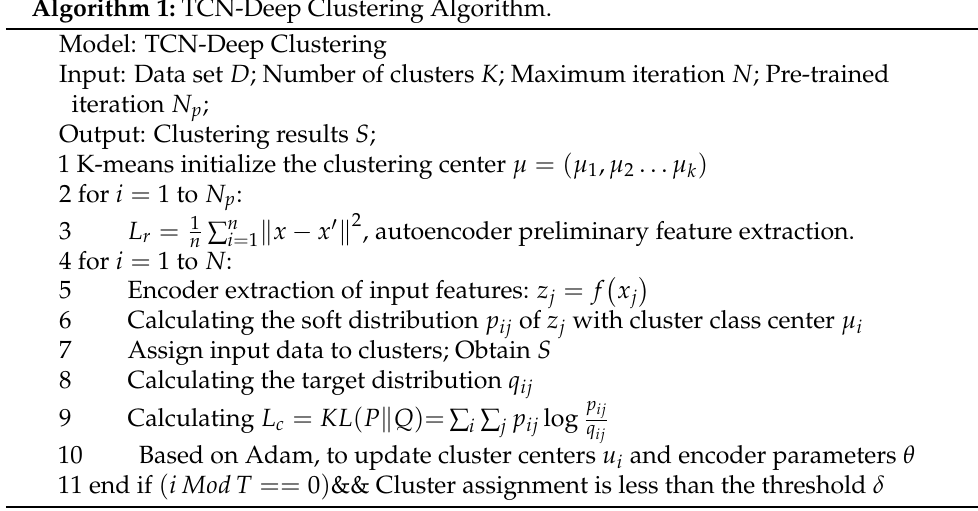
Algorithm 1: TCN-Deep Clustering Algorithm. Model: TCN-Deep